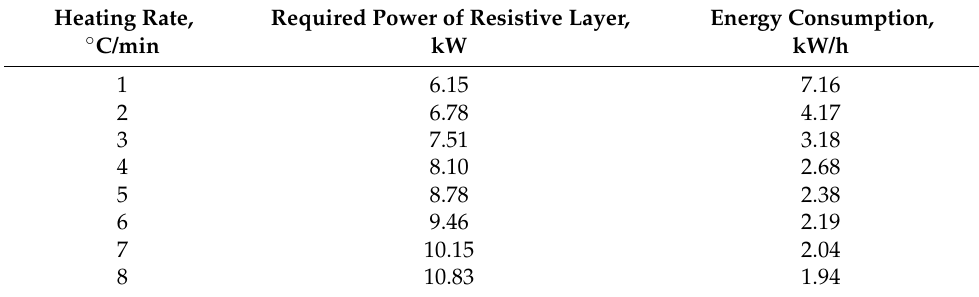
Table 1. Required power and energy consumption values for different heating rates. Heating Rate, ◦